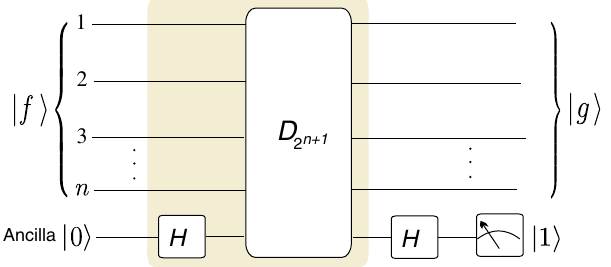
FIG. 9. Quantum circuit for the QHED algorithm with an auxiliary qubit. H is a Hadamard gate, and D 2 n þ 1 is an amplitude permutation operation for n þ 1 Fig. 9. The operation D 2 n þ 1 is an n þ 1 -qubit amplitude